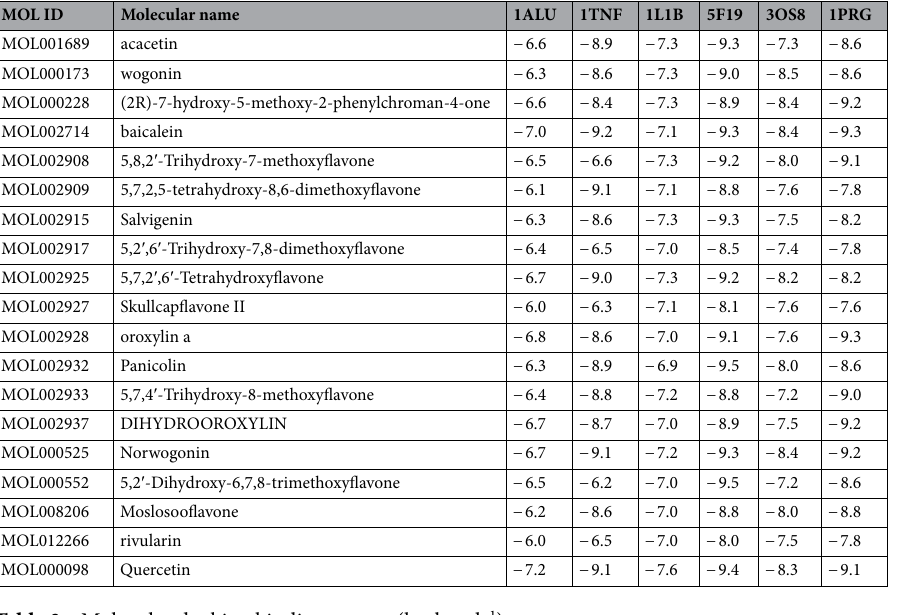
Table 3. Molecular docking binding energy (kcal mol −1